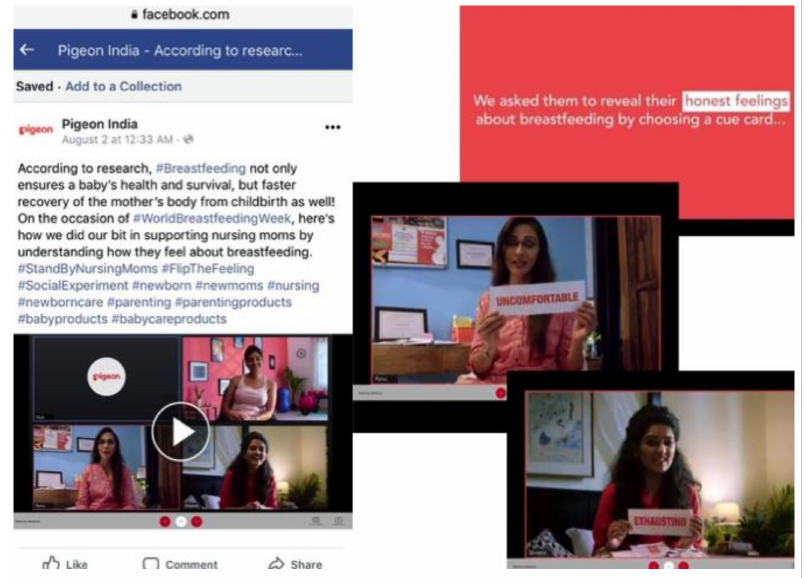
Figure 9. Screenshots of Pigeon India’s #standbynursingmoms campaign video from Facebook, with women revealing their “honest feelings” about breastfeeding as “uncomfortable” and